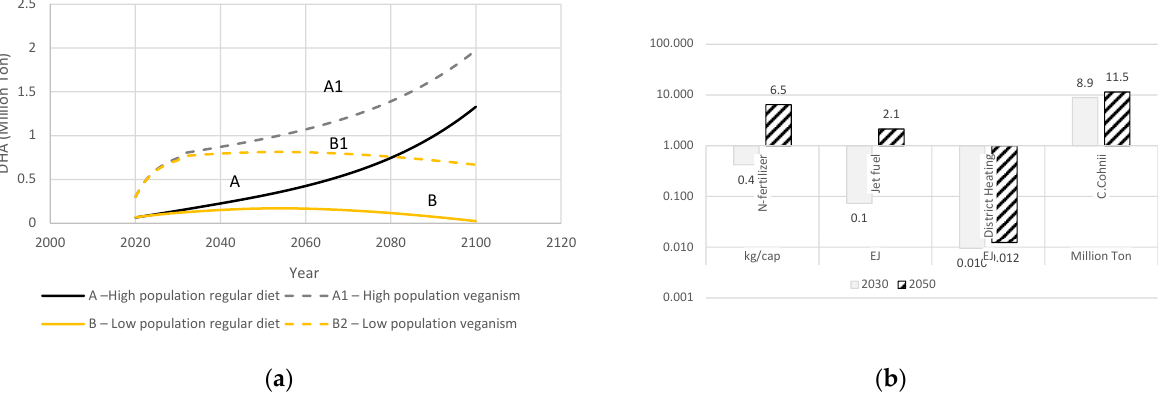
Figure 12. ( a ) DHA needs from alternative sources other than fish, ( b ) C. cohnii supply needs (higher- end estimates for 100% DHA coverage) and potential coverage of N-fertilizer, jet-fuel, and district heating (0.14 g/L/h C. cohnii dry productivity and 27% oil content).